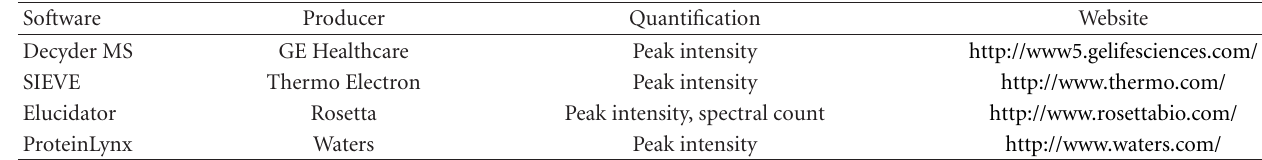
Table 1: Commercially available software for label-free